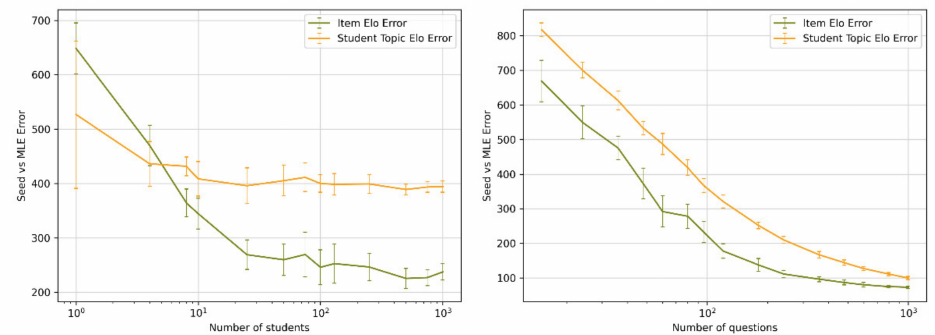
Figure 3. Mean error of MLE calculated values as compared to seed values used in the generation of synthetic students. On the left mean error is a function of group size. On the right mean error as a function of quiz